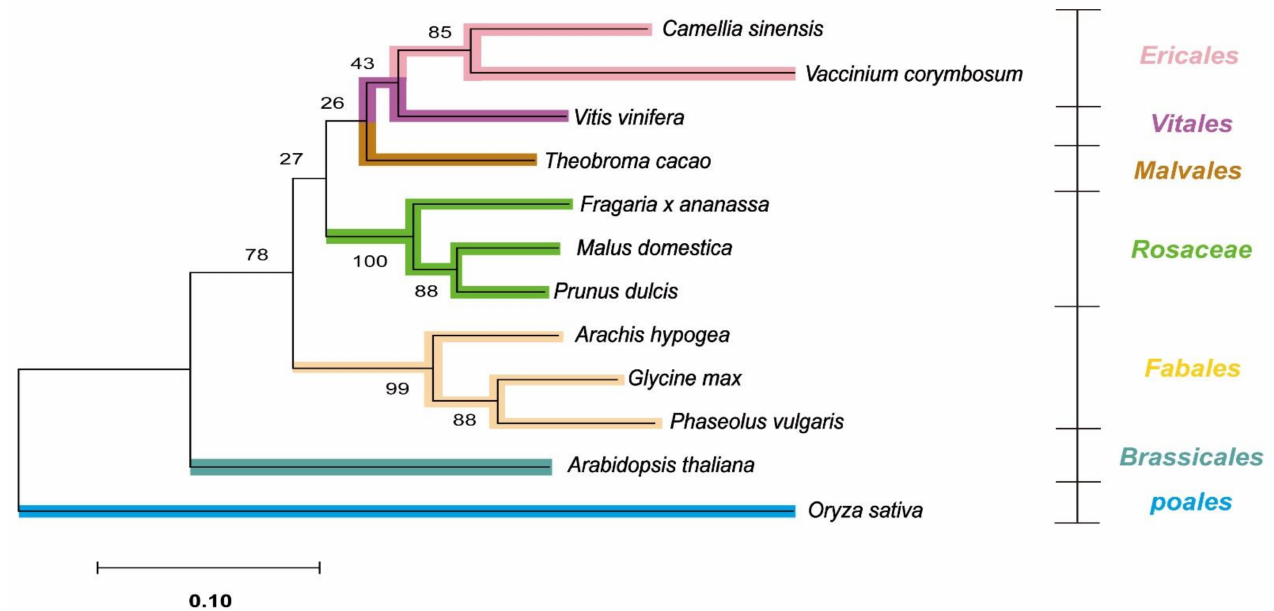
Figure 2. The phylogenetic tree was constructed using three genes: ANR , ANS , and DFR . The protein sequences of the three genes were obtained from the reference genomic data of the 12 species (including Oryza sativa as an outgroup). The protein sequences were concatenated and aligned using the MUSCLE algorithm, and the analysis was performed using the maximum likelihood method. The numbers between nodes are bootstrap values indicating the reliability of the genetic tree, and branches have been colored with their family indicated on the right-hand side of the figure. ANR: anthocyanidin reductase; ANS: anthocyanidin synthase; DFR: dihydroflavonol